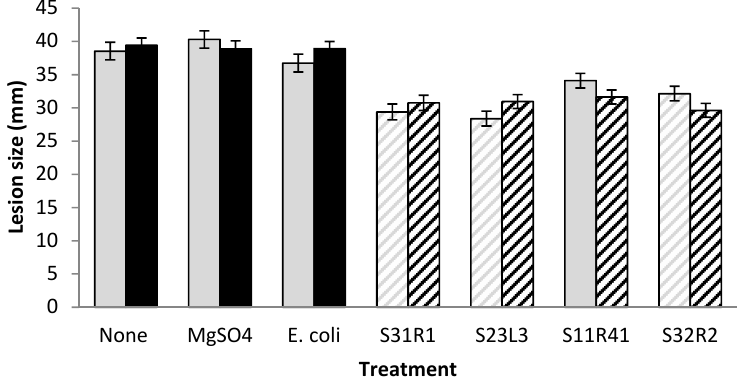
Figure 2. Size of F. circinatum lesions on two-year-old P. radiata trees treated with pine rhizobacteria. Values shown are the means of at least 30 lesions ± standard error in two separate experiments (Exp. 1, solid and hatched grey bars; Exp. 2, solid and hatched black bars); hatched bars indicate lesions that are significantly different from those on untreated ( F. circinatum only) trees ( p < 0.05).